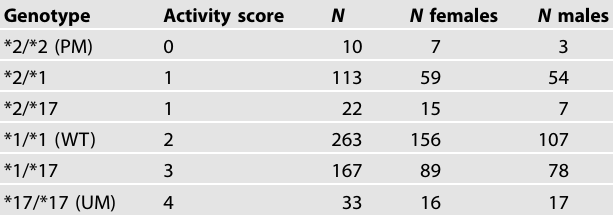
Table 1. Genetic composition of the sample.